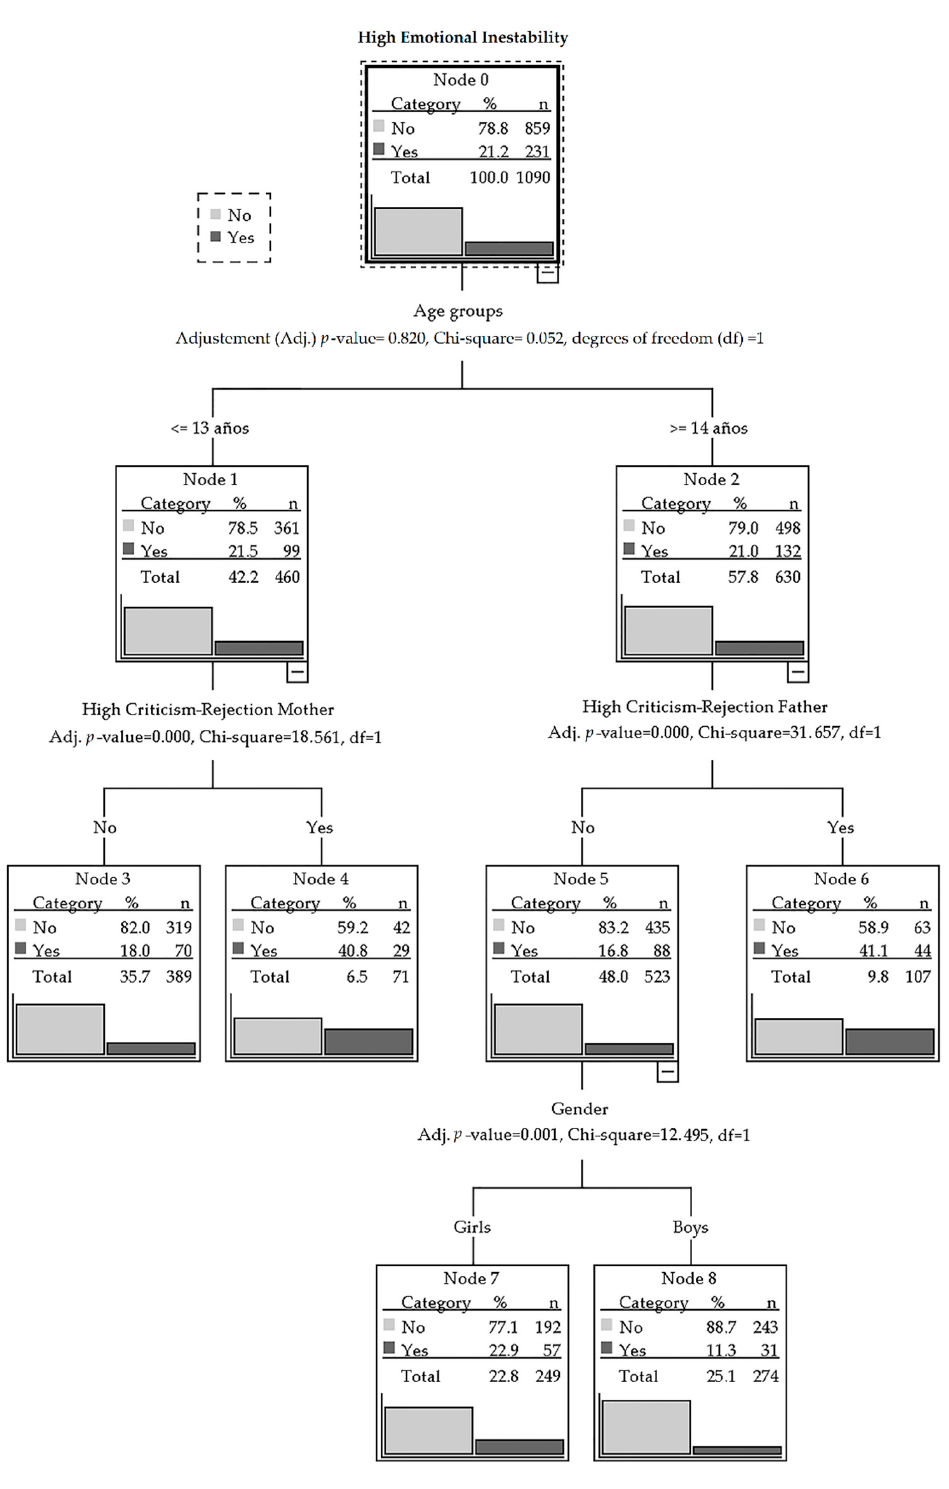
Figure 1. Classification tree for high emotional instability.